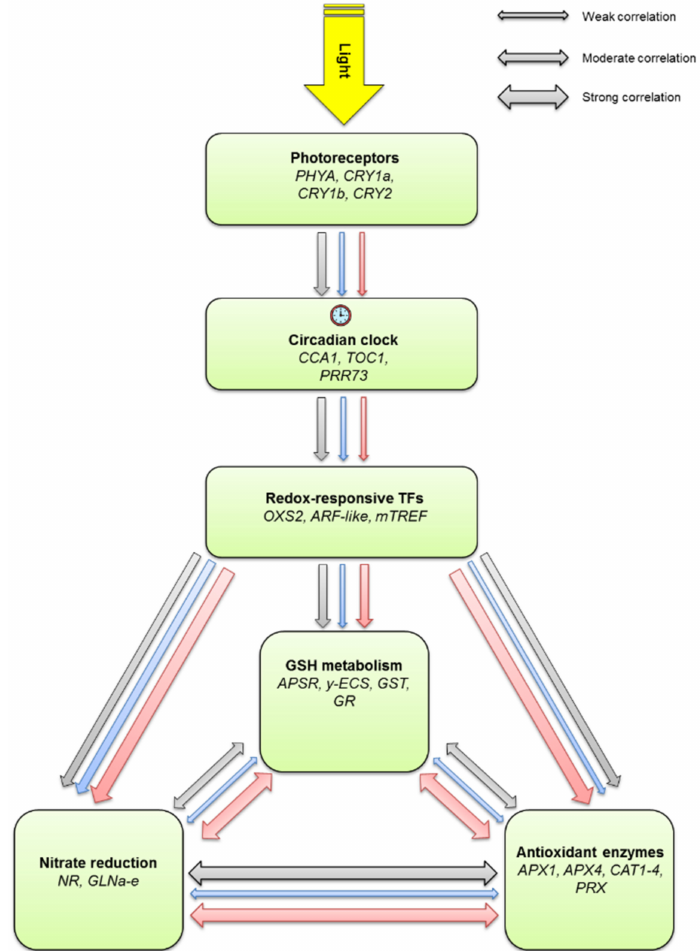
Figure 7. Putative spectral control of the diurnal changes in the transcription of the genes related to nitrate reduction, glutathione metabolism and antioxidant enzymes based on the correlation analysis. Green squares indicate the groups of evaluated genes related to different processes, one-way arrows show hypothetical regulatory effect, while duplex arrows indicate possible interactions between the different metabolic pathways. Three different arrow thicknesses indicate the level of correlation (weak, moderate and strong), spectral effect is represented by gray (normal white light), blue (supplemental blue light) and red (supplemental far-red light) colors. Correlation analysis was performed according to [69]. The correlation between different groups was considered “strong” if there was at least one pair of genes with “very high” (0.90–1.00) or “moderate” correlation, if there was at least one pair with “high” (0.70–0.90) correlation value and “weak” if correlation values were less than 0.7 (for details, see Supplementary Tables